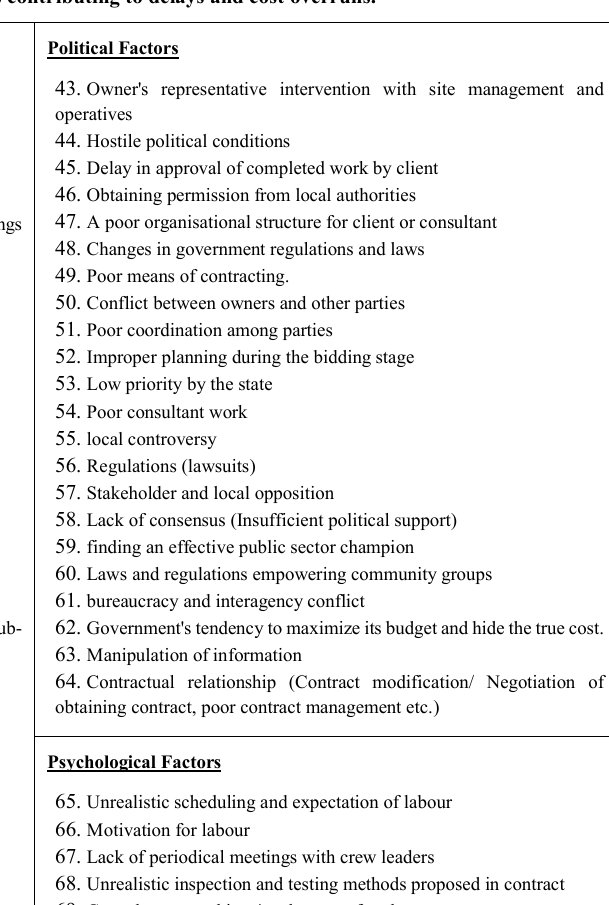
Table 1. Compiled list of factors contributing to delays and cost